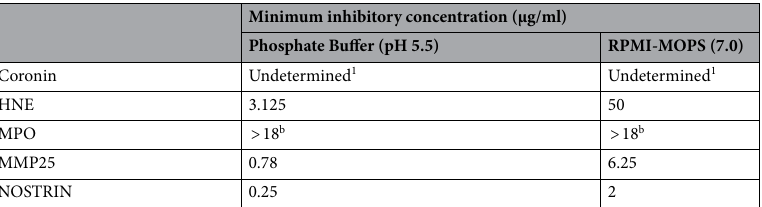
Table 1. Minimum Inhibitory Concentrations (MIC) of Anti-cryptococcal Lysosomal Proteins in Phosphate Buffer (pH 5.5) or RPMI-MOPS (pH 7.0). a ODs of the protein were higher than yeast growth. b Growth present in the highest tested